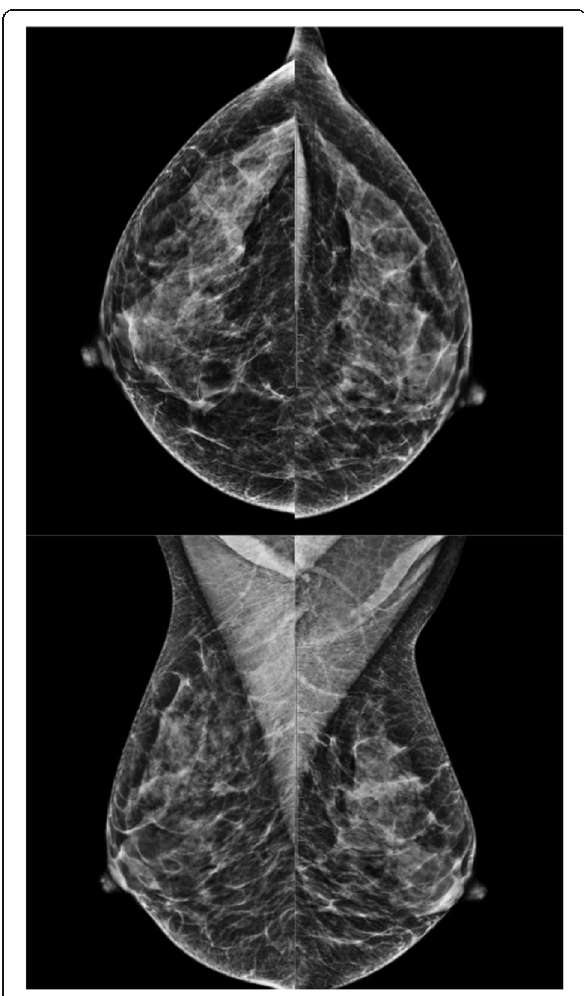
Fig. 5 Mammography positioning. Craniocaudal and mediolateral oblique 2D mammograms show the nipples are perfectly